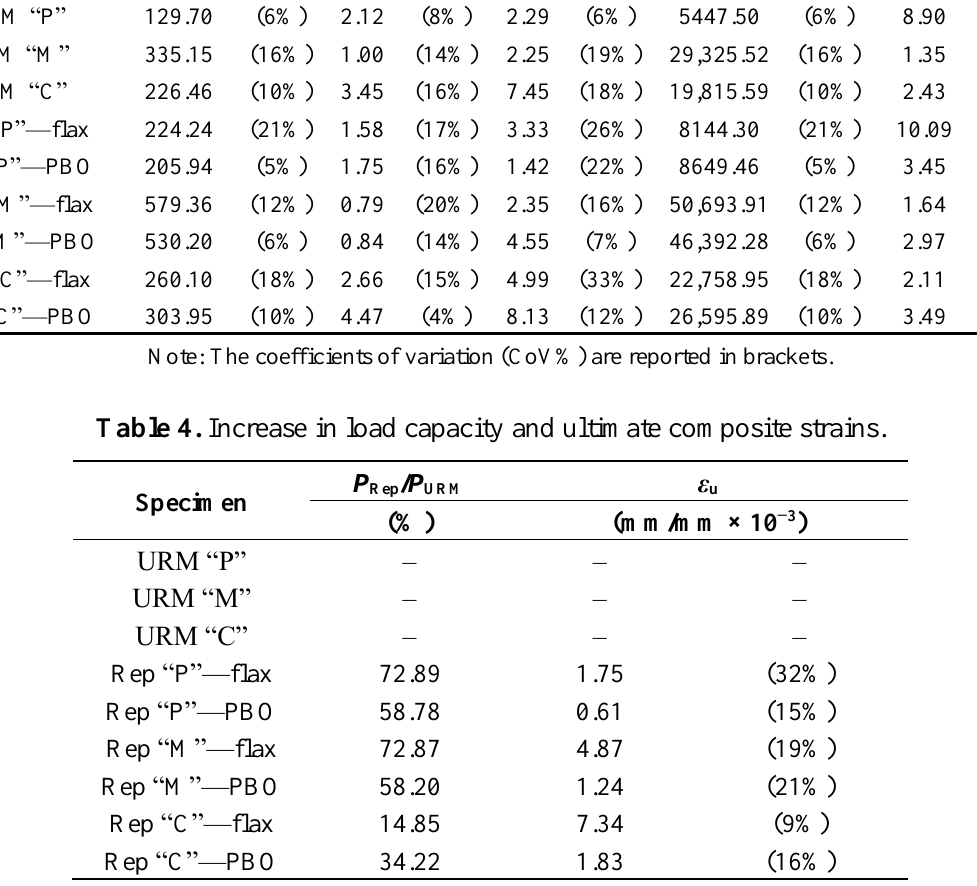
Table 3. Results of eccentric load test conducted on URM and repaired masonry elements. P max Specimen